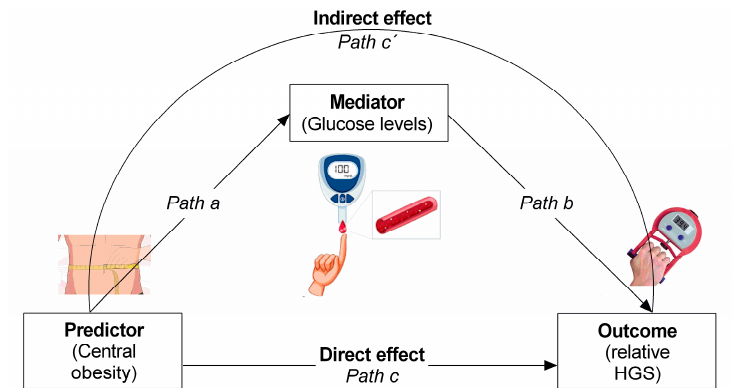
Figure 2. Mediation analysis tests a hypothetical causal chain where one variable X (abdominal obesity status) affects a second variable M (fasting glucose levels) and, in turn, that variable affects a third variable Y (HGS, relative handgrip strength).